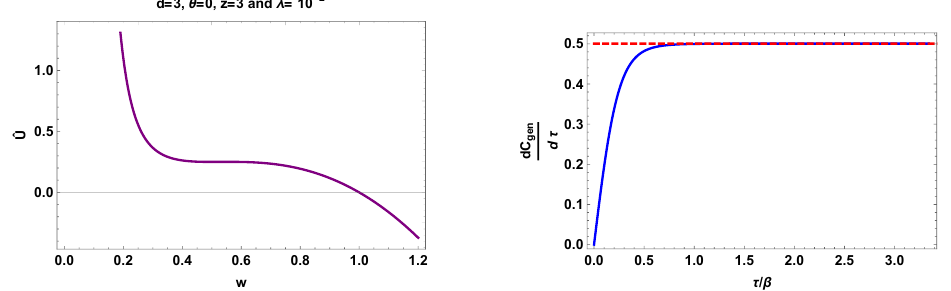
Figure 16 . The case d = 3 , θ = 0 , z = 3 and λ = 0 . 01 : Left ) The effective potential as a function of w . For this value of λ there is just one maximum w . It is located inside the horizon and is the solution fB 1 to equation B ( λ, w ) = 0 . Right ) The growth rate d C gen in terms of τ/β . The late time growth rate dτ is linear at late times and its value indicated by the red dashed horizontal line is given by eq. (3.23).